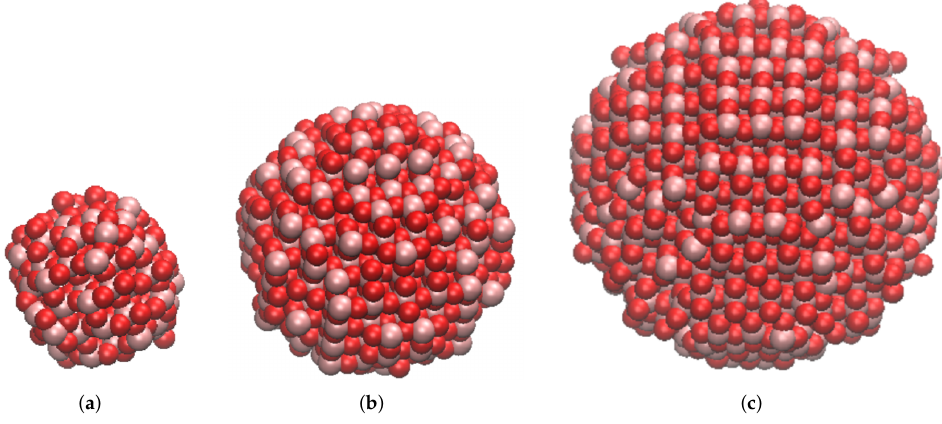
Figure 1. TiO 1.5 nm; ( c ) Ti